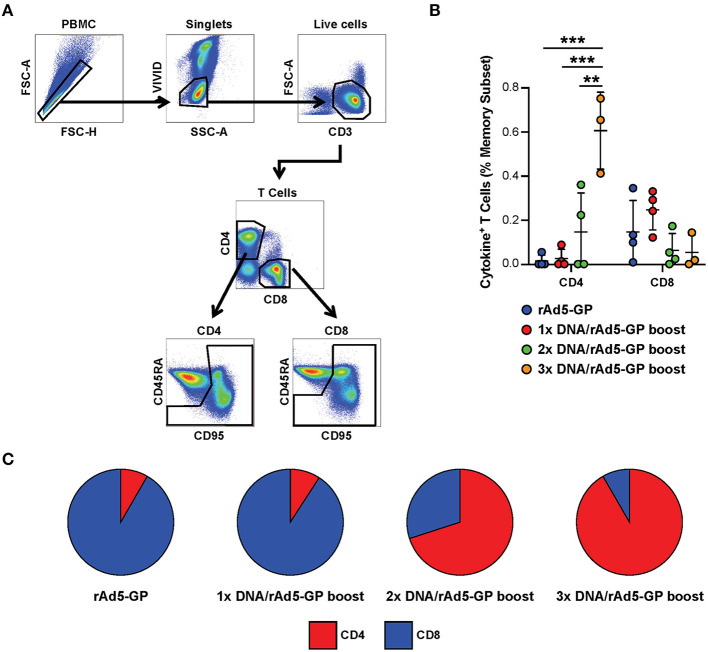
Reduction of DNA priming reverses the CD4/CD8 ratio in heterologous DNA prime rAd5 boost vaccination. Ebola GP reactive CD4+ and CD8+ T-cells secreting any of the three cytokines measured (IFNg, IL-2, or TNFa) were detected in the memory (CD95+CD45RAhi and CD95+CD45RAlo) subset of the NHP's PBMCs following 6 h in vitro stimulation with EBOV GP peptide pool or DMSO control. (A) T-cell gating tree. (B) Magntitude of cytokine positive T-cells in animals vaccinated with: rAd5 GP (blue), 1x DNA prime-rAd5-GP boost (red), 2x DNA prime-rAd5-GP boost (green), and 3x DNA prime-rAd5-GP boost (orange). (C) The relative proportion of CD4+ or CD8+ T-cell responses in each group. Statistical analysis between more than two groups was performed using a one-way ANOVA with Tukey's post hoc test; **p < 0.01, ***p < 0.001; mean ± standard deviation shown.